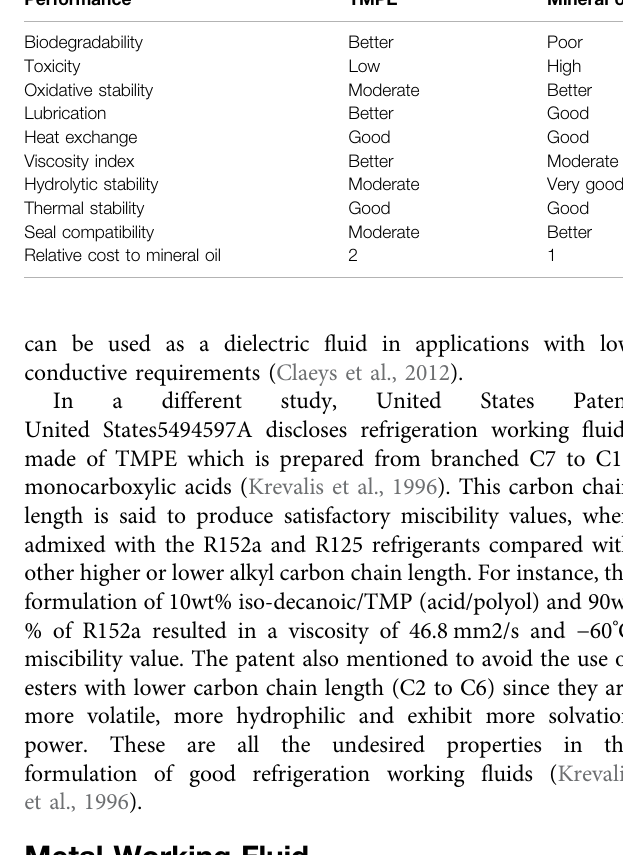
TABLE 10 | Comparison of properties of trimethylolpropane ester (TMPE) and mineral oil as MWF (Benedicto et al., 2017).